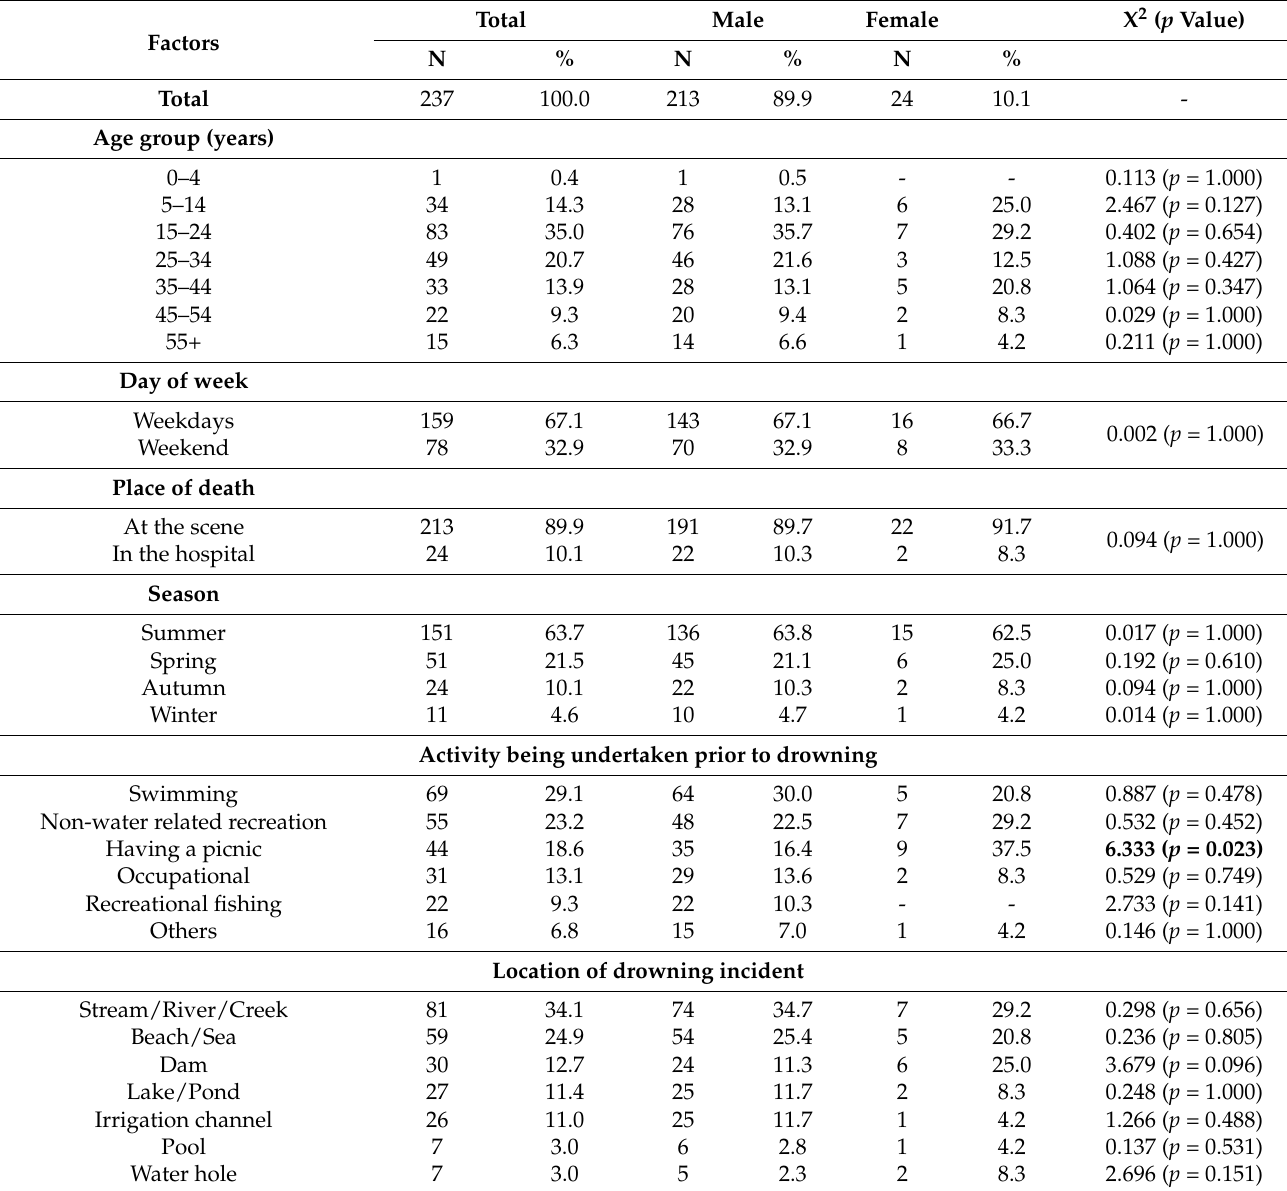
Table 2. Fatal drowning of bystander rescuers by sex, X 2 ( p value), Turkey,